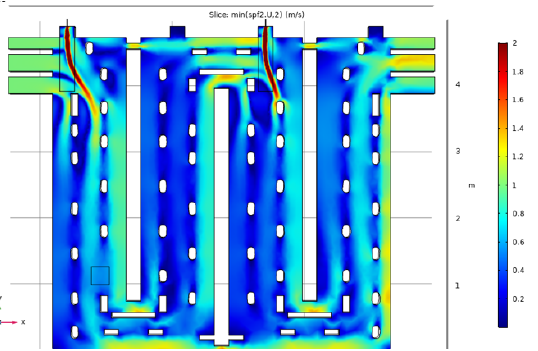
Figure 10. Model 7: artificial diffusion δ = 0.25 u ,p using mesh 3. Initial value for the Newton Raphson method: zero. Dimensions m/s.